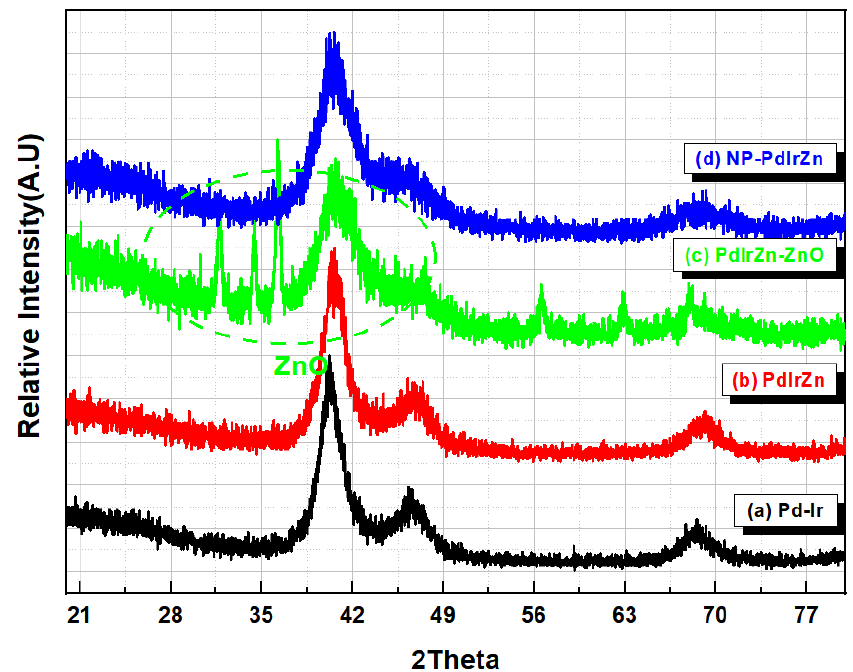
Figure 3. XRD patterns of ( a ) PdIr, ( b ) PdIrZn, ( c ) PdIrZn–ZnO, and ( d ) NP-PdIrZn catalysts.